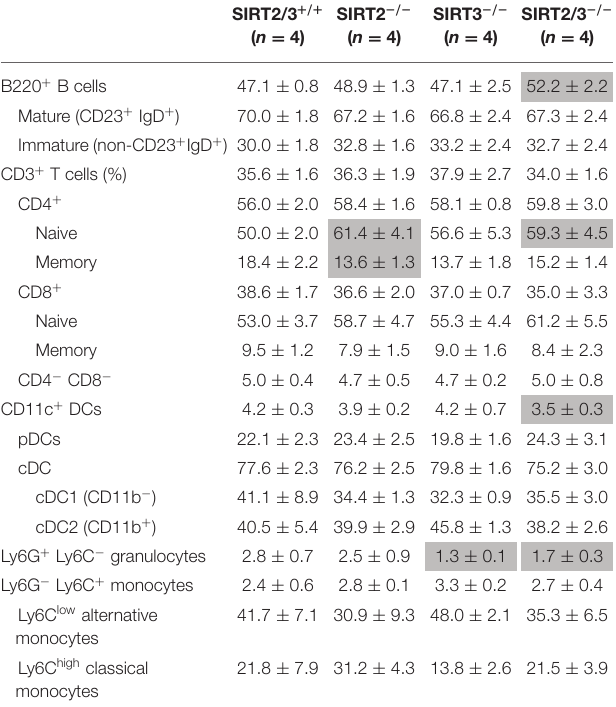
Data are mean ± SD of four mice per group and expressed as percentage of total cells (B220 + , CD3 + , CD11c + , Ly6G + Ly6C − , Ly6G − Ly6C + ) or percentage of parental cells. Spleen weights were 103.8 ± 10.3, 119.3 ± 20.0, 94.5 ± 7.5, and 108.8 ± 10.0mg for SIRT2/3 + / + , SIRT2 − / − , SIRT3 − / − , and SIRT2/3 − / − mice. Gray background: P < 0.05 vs. SIRT2/3 + / + mice.